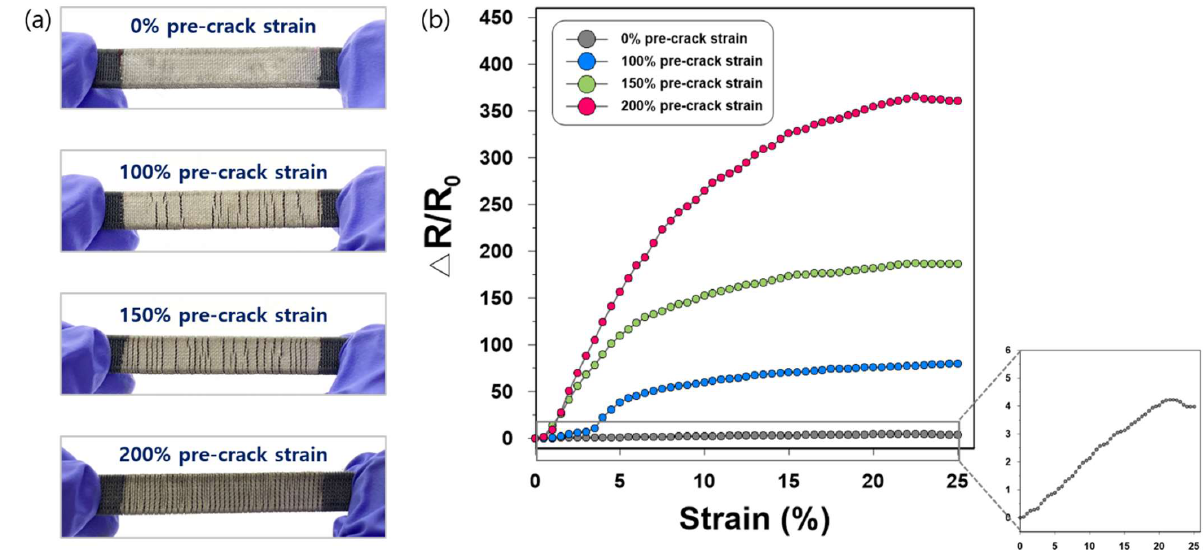
Figure 5. ( a ) Crack images for the pre-cracked strain sensors according to pre-stretching strains of 0%, 100%, 150%, and 200%; ( b ) Relative changes in resistance versus strain of samples pre-stretched at 0%, 100%, 150%, and 200% strain.